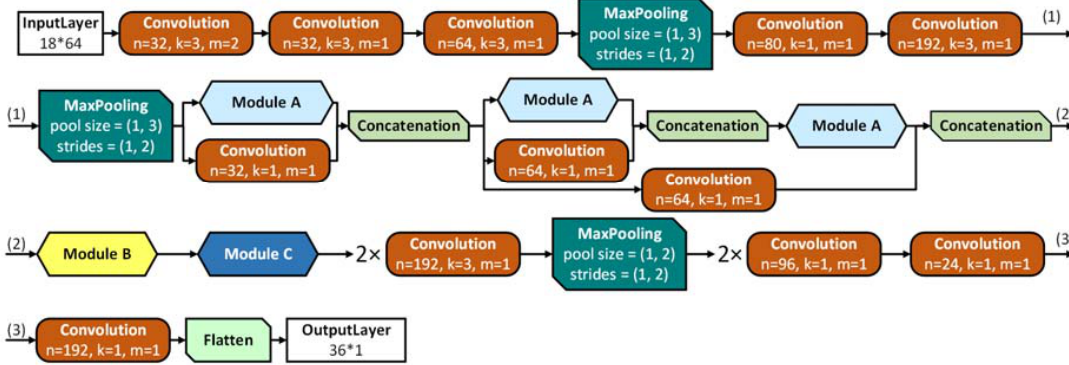
Figure 3. Representation of the full inception ‐ like neural network (NN) for 64 channels. The input matrix of 18 × 64 was converted by the NN into an 18 × 2 matrix and concatenated into a 36 × 1 by a flattening layer. The first layers are traditional sets of convolutions, followed by pooling layers for grid reduction. Next, a sequence of 3 modules of type A was applied, followed by modules of type B and C. For the first two A modules, additional convolutions were concatenated to keep the balance between network width and depth. An additional convolution was added to concatenate the output of the first and third module A to demote the vanishing gradient problem. For 8 and 16 channels the structure was similar with the strides decreased to 8 and 16 convolutions, respectively.